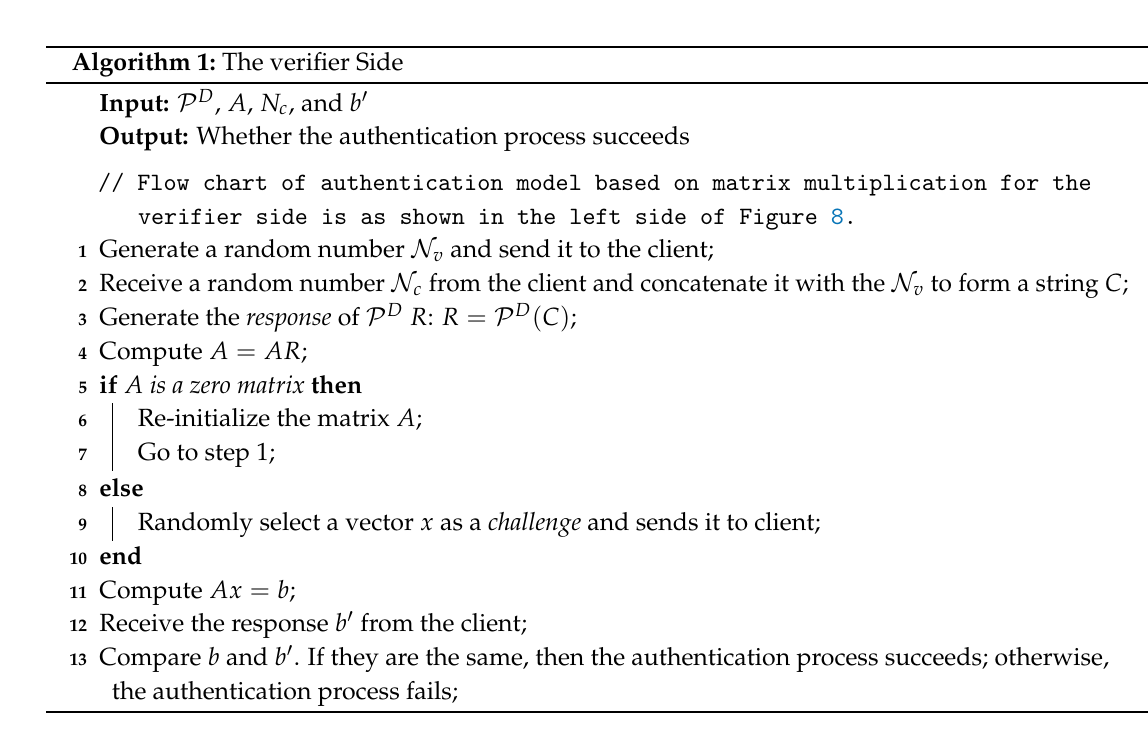
Figure 7. Steps of authentication model.